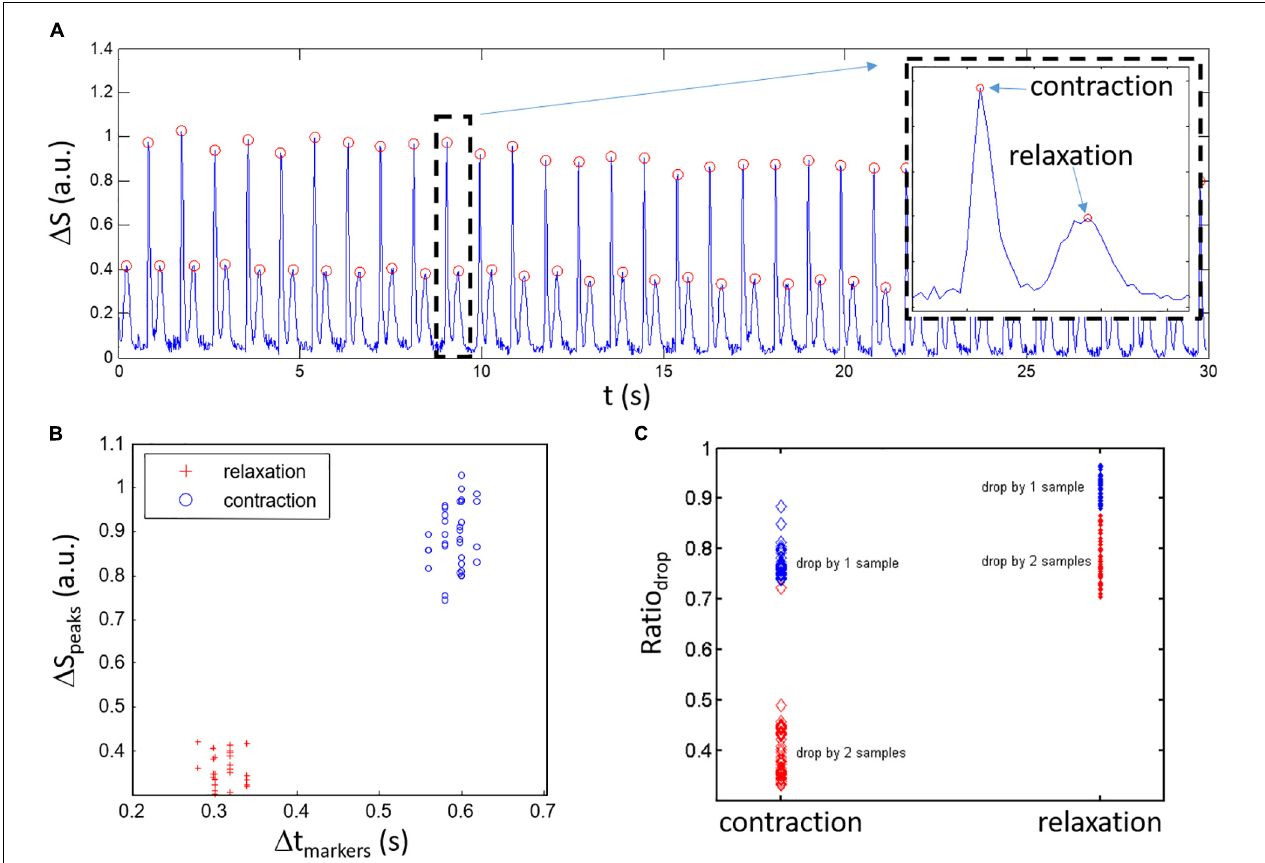
FIGURE 3 | Classification of (cid:49) S peaks for a spontaneously beating sample. (A) An example of composite signal (cid:49) S with detected peaks (red circles) showing alternation between high amplitude and low amplitude peaks. Inset: blow up of the activity within the dashed black rectangle which highlights the high amplitude contraction peaks followed by the lower amplitude relaxation peak like the derivative of the simulated contraction model. (B) Contraction and relaxation clusters are relatively well separated when viewed in the space with x -axis being the time between markers and y -axis being the peak amplitude ( (cid:49) S peaks ). (C) Estimation of the change in (cid:49) S around the peaks given by the Ratio drop (amplitude of 1st and 2nd samples around the peaks divided by the peak amplitude). Lower ratio Ratio drop is linked to faster change in (cid:49) S around the peaks for the contraction peaks compared to the